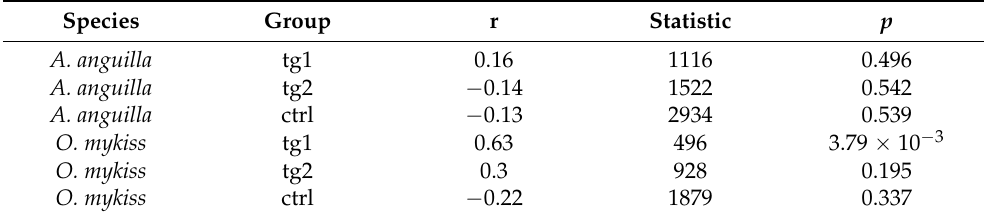
Table 3. Statistical details of the correlation tests between cortisol concentrations measured in blood serum and skin mucus. r: correlation coefficient.